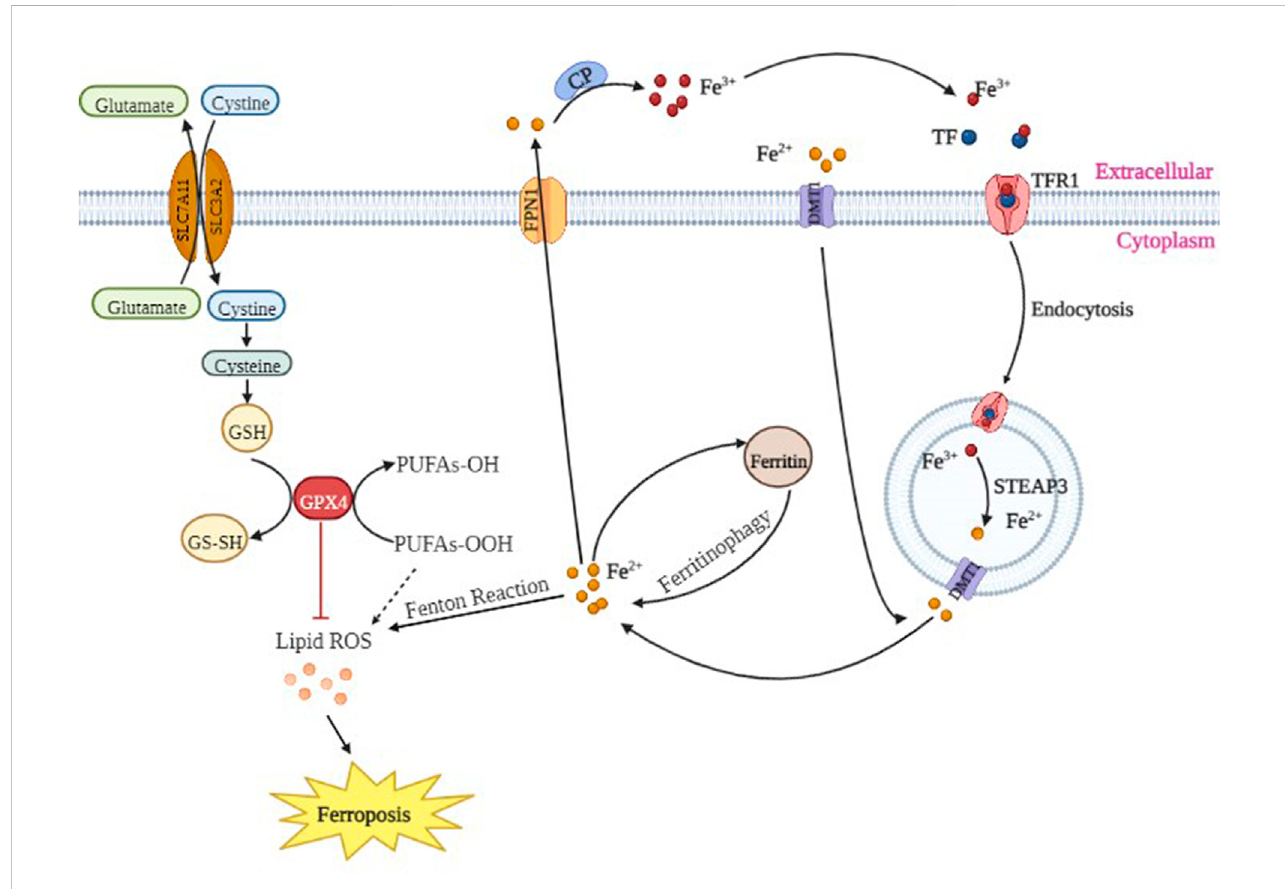
FIGURE 10 The molecular mechanisms of